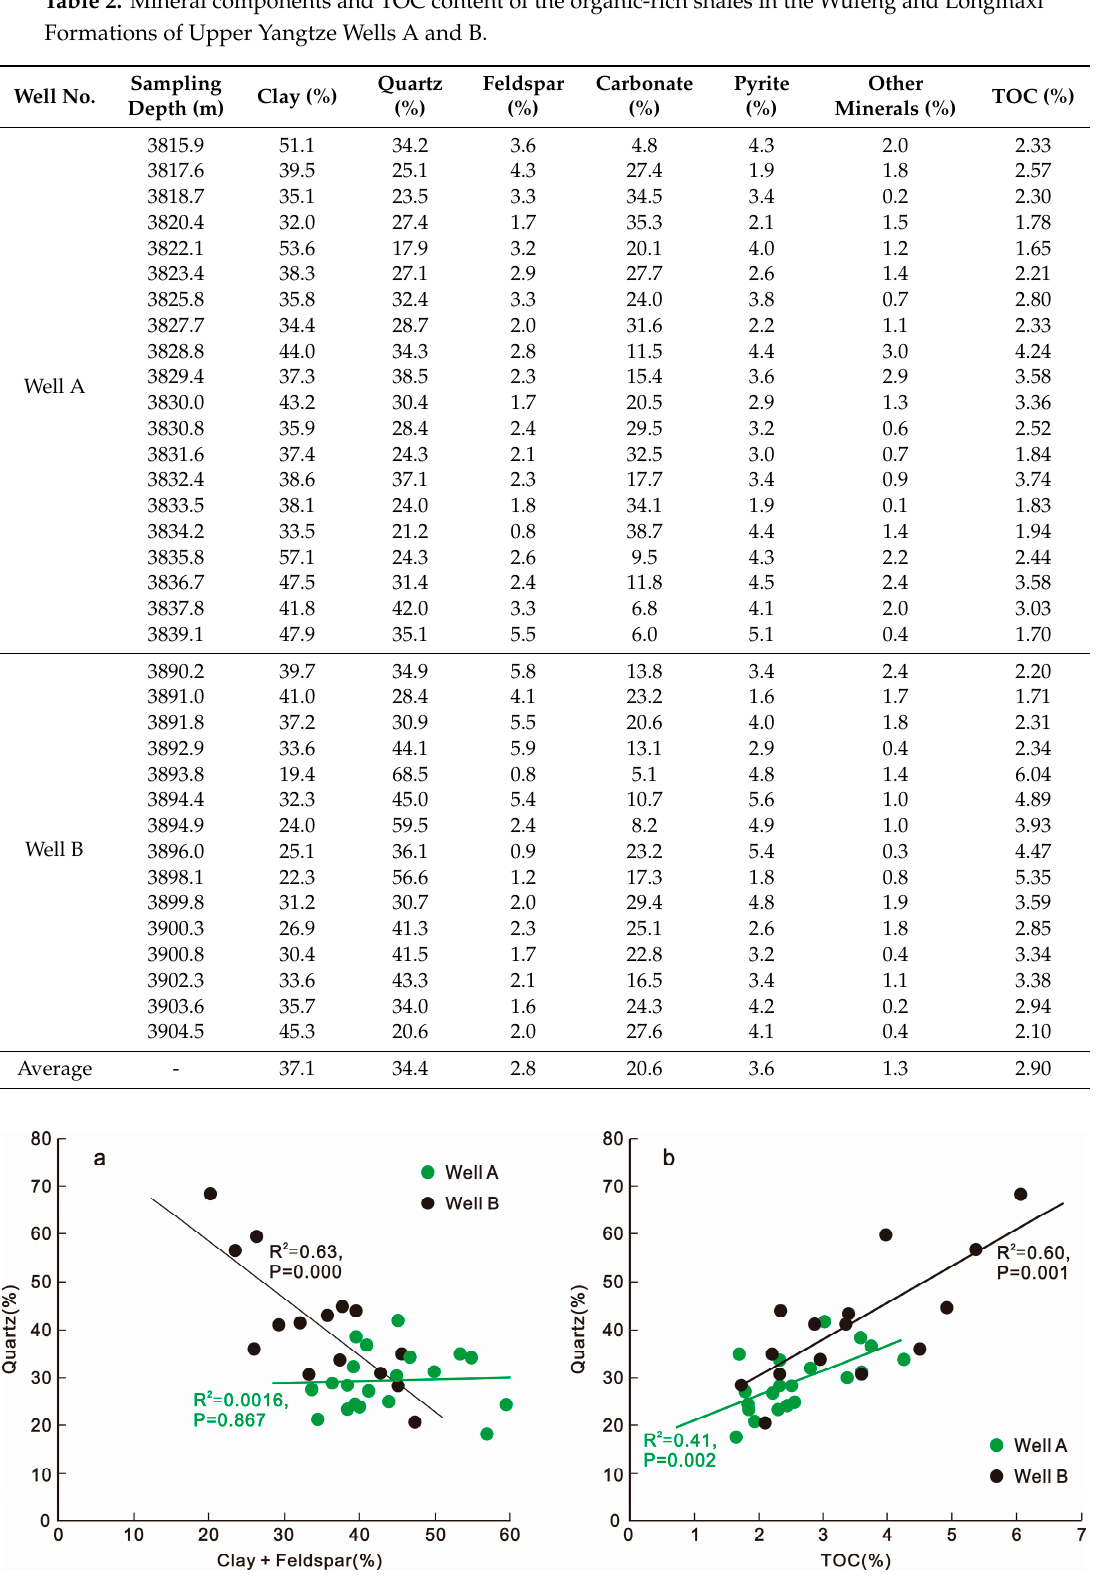
Figure 5. Characteristics of siliceous organisms of the organic-rich shales in the Wufeng and 239 Longmaxi Formations of the Upper Yangtze region shown in thin sections. 240